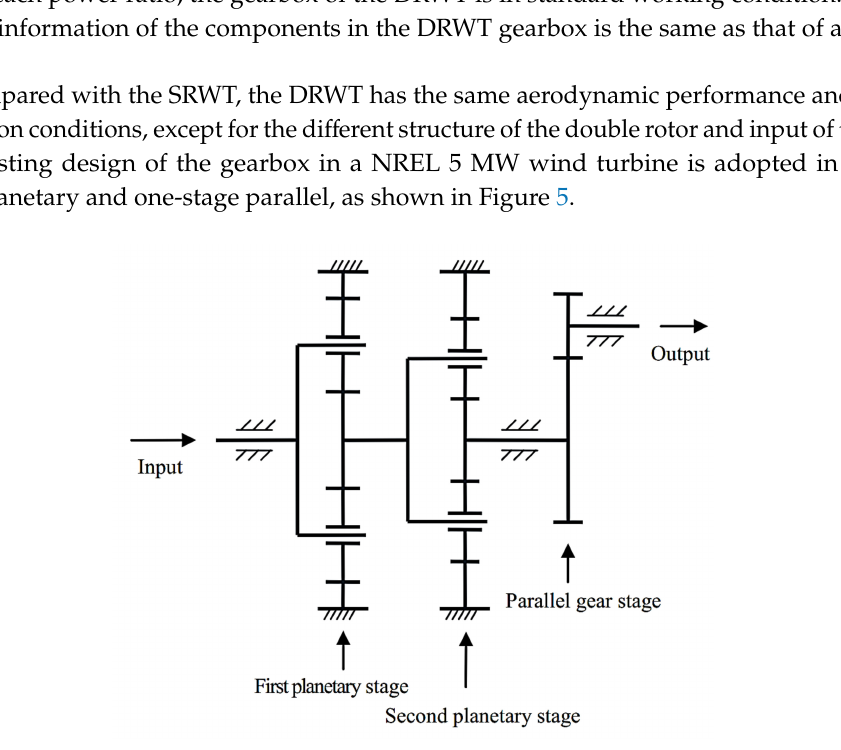
Figure 5. Structure diagram of gearbox of NREL 5 MW single-rotor wind turbine